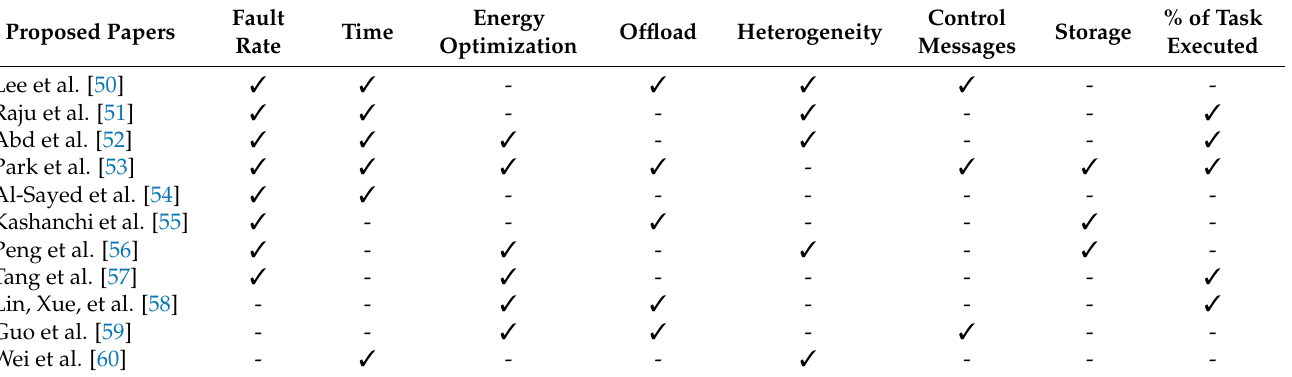
Table 1. Comparison of IOT-based task